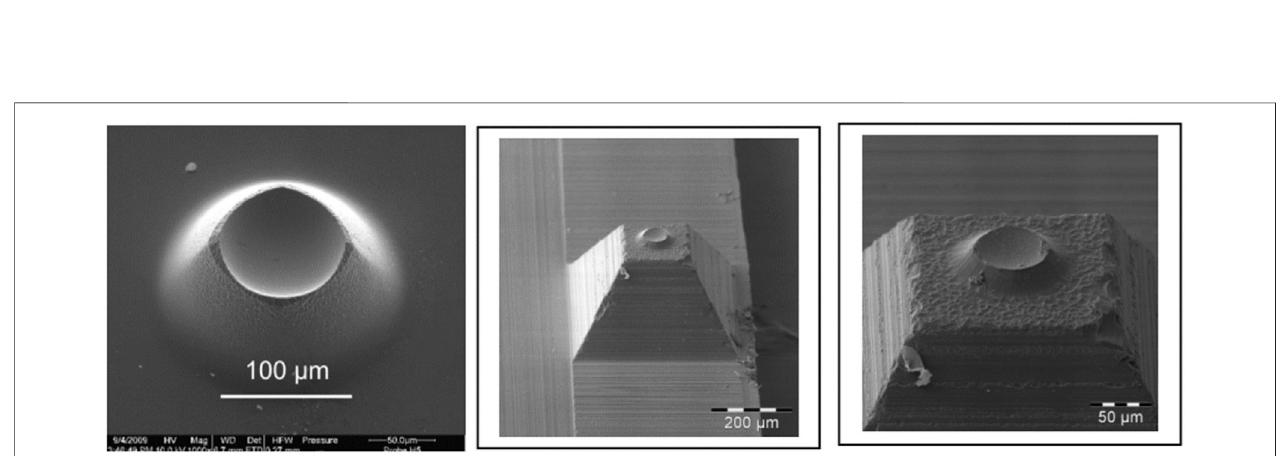
FIGURE 7 | Specially designed acoustic lens for GHz ultrasonic transducer device.